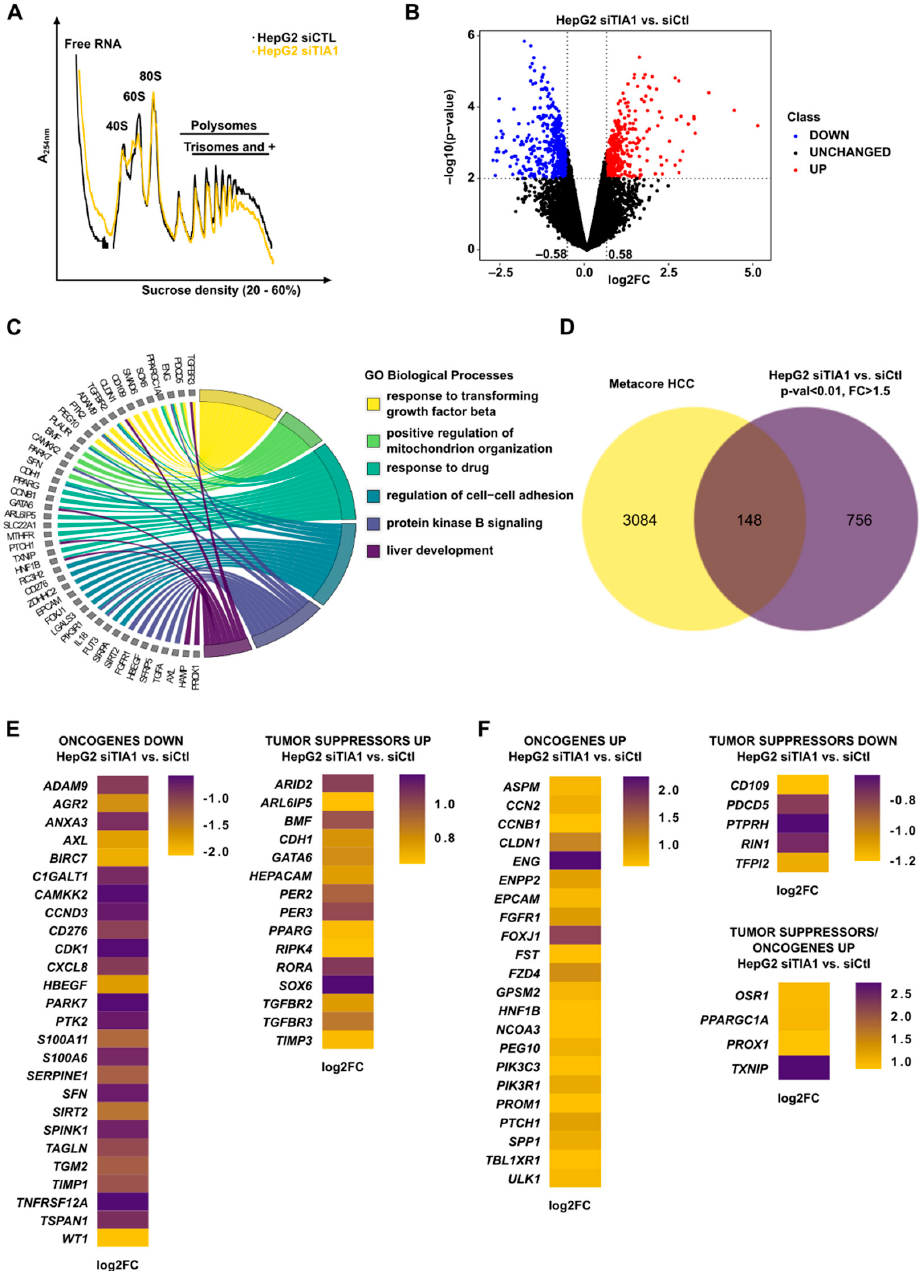
Figure 2. TIA1 regulates the expression of numerous oncogenes and tumor suppressors. ( A ) Repre- sentative polysome profiles of HepG2 ± siTIA1. ( B ) Deregulated genes following an RNA sequencing of polysomal (3+) fractions of HepG2 ± siTIA1. ( C ) Most relevant enriched biological processes (BPs) with their genes involved (GO BP, FDR < 0.1). ( D ) Venn diagram showing deregulated genes crossed with a list of genes associated with HCC based on the literature (retrieved from the MetaCore database). ( E , F ) The expression of deregulated tumor suppressors (TS) and oncogenes (ONC) in HepG2 ± siTIA1. Data were represented as mean ± SD. Unpaired t-test was used for comparison of two groups, unless specified otherwise.